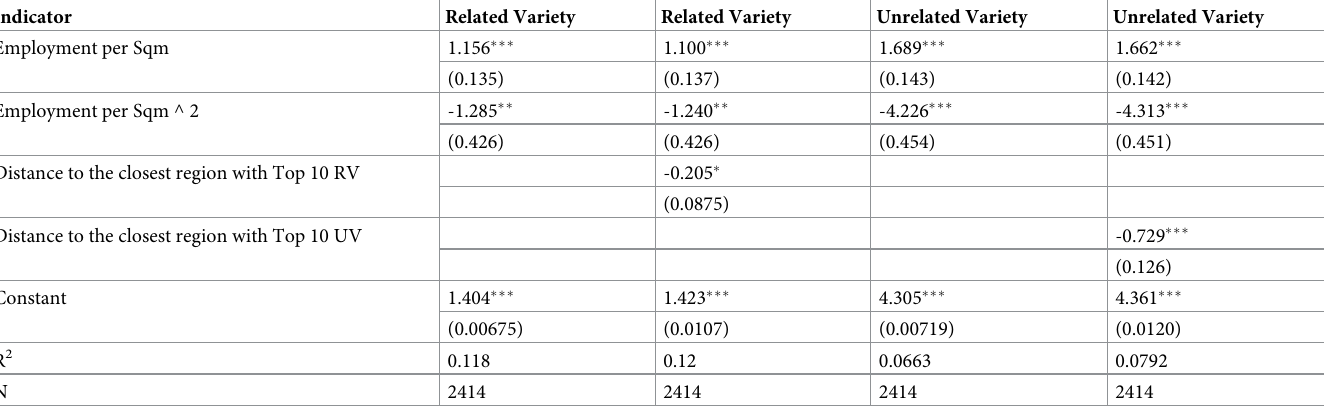
Table 3. Relation of stage of development and distance to frontier with UV and